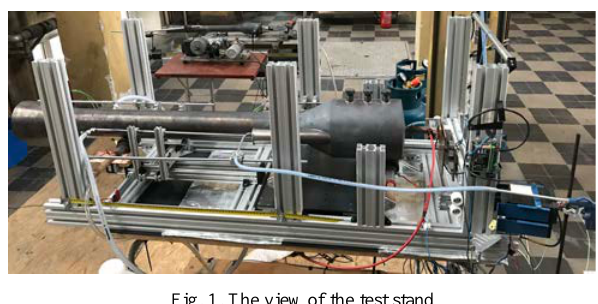
Fig. 1. The view of the test stand